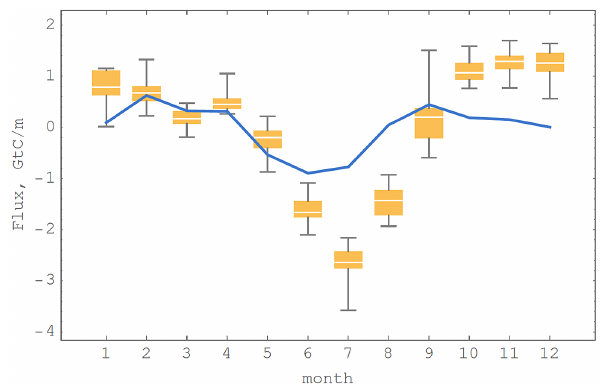
Figure 3. The seasonal cycle of N a,mod (blue) for WUE = 1.8gCL − 1 , Q 10 = 2.0, and φ = 0, as compared to the detrended TransCom 3 seasonal CO 2 flux (orange) estimated from atmospheric inversions (Gurney and Denning,